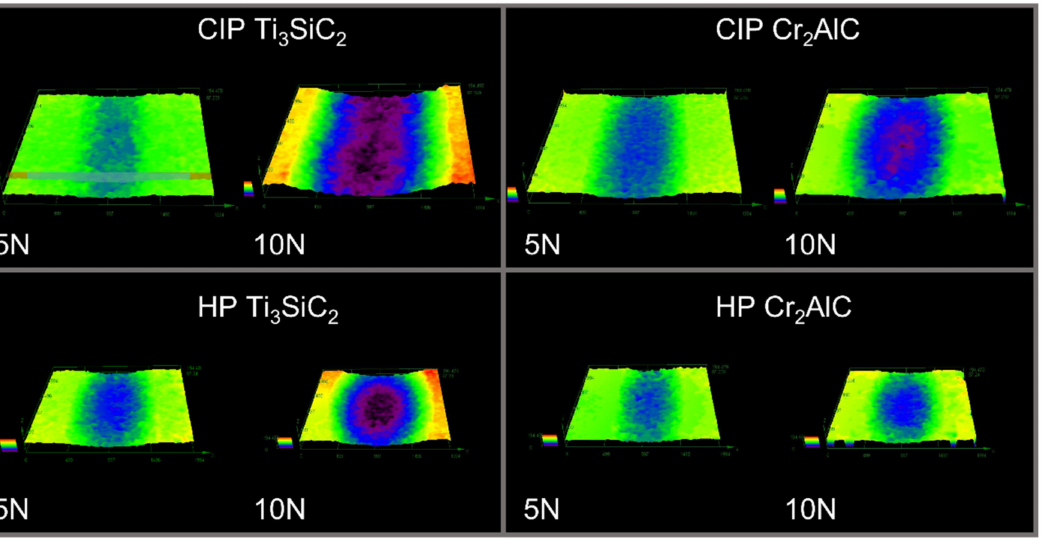
Figure 15. 3D profile images of the wear tracks for the Ti 3 SiC 2 and Cr 2 AlC MAX phases produced by cold isostatic pressing (CIP) and hot pressing (HP) at different wear test